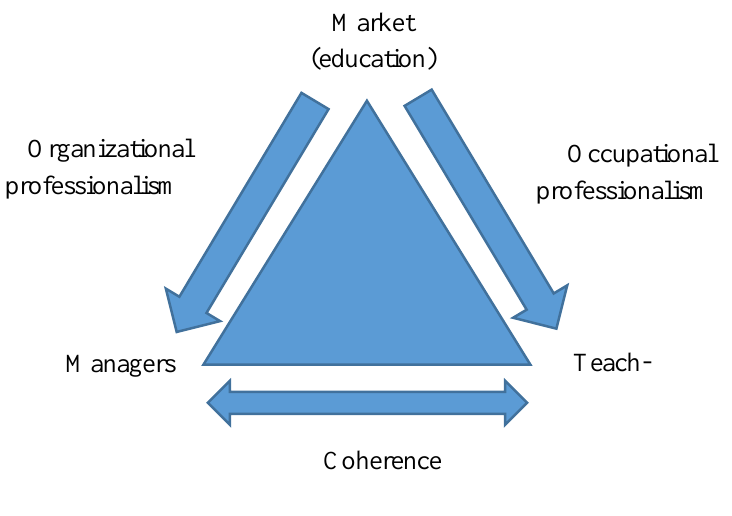
Figure 1 . The transition from the course to the